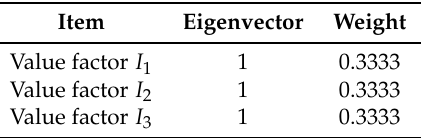
Table 10. Calculation of W i from I